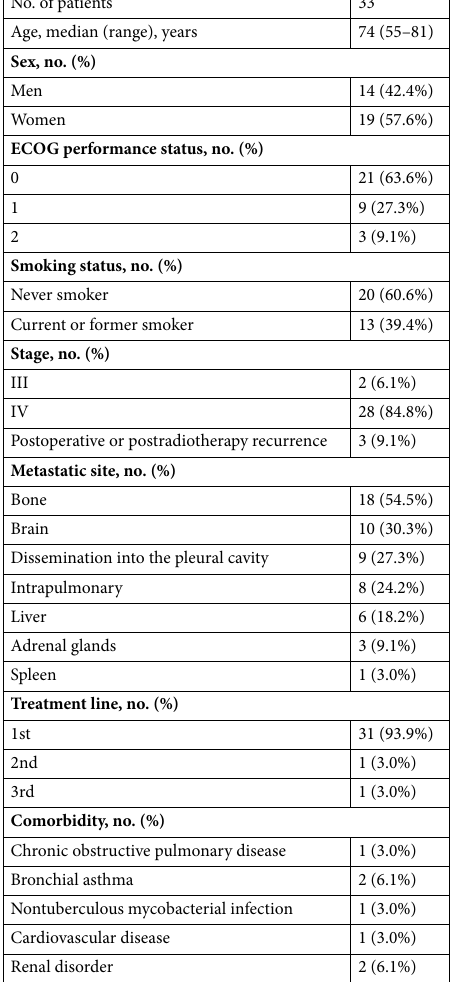
Table 1. Baseline patient and tumor characteristics. Abbreviation: ECOG Eastern Cooperative Oncology